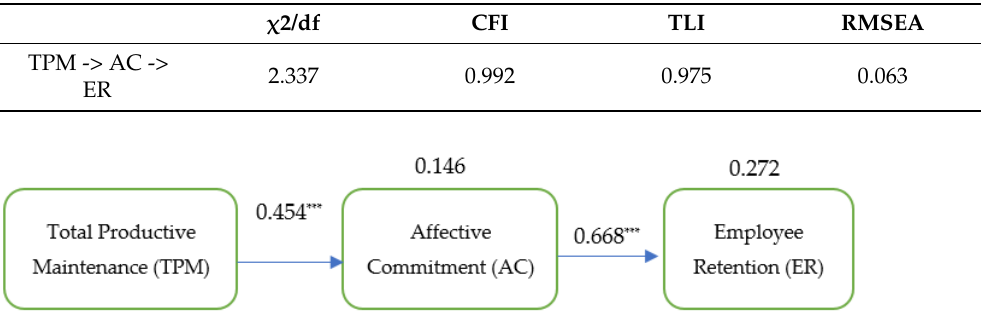
Table 3. Fit indices.